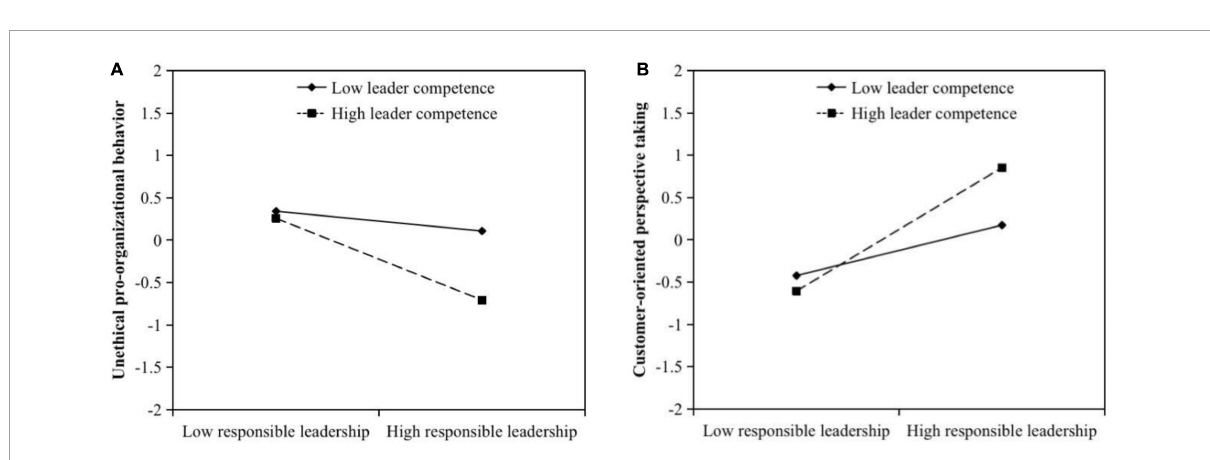
FIGURE3 The moderating effects of leader competence on (A) the relationship between responsible leadership and unethical pro-organizational behavior and (B) the relationship between responsible leadership and customer-oriented perspective